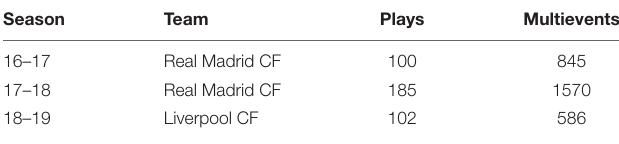
TABLE 1 | Distribution of offensive actions analyzed by team and